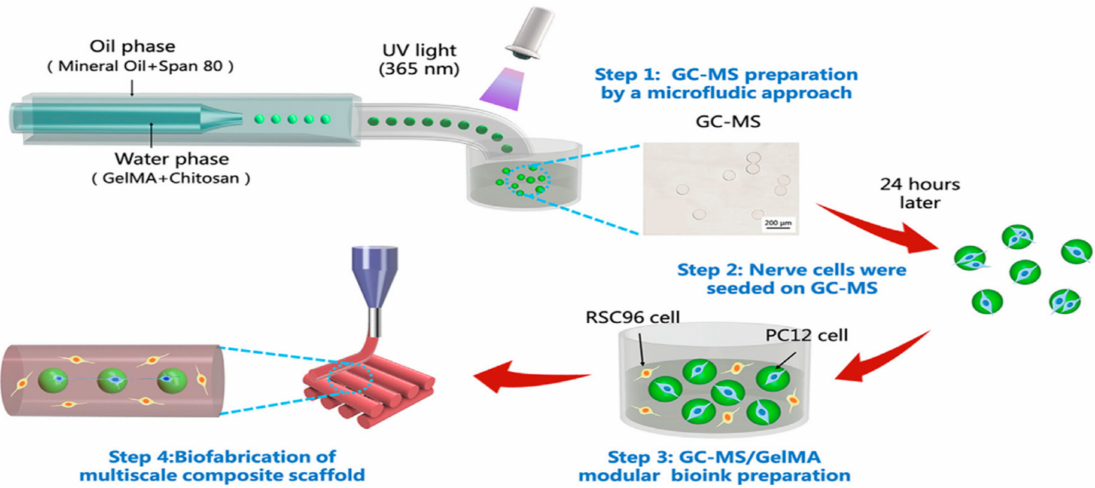
Figure 2. Multiscale composite sca ff old preparation based on a gelatin methacryloyl (GelMA) / chitosan microspheres (GC-MSs) modular bioink: GC-MS preparation by a microfluidic approach (step 1), nerve cells seeded on GC-MS (step 2), GC-MS / GelMA modular bioink preparation (step